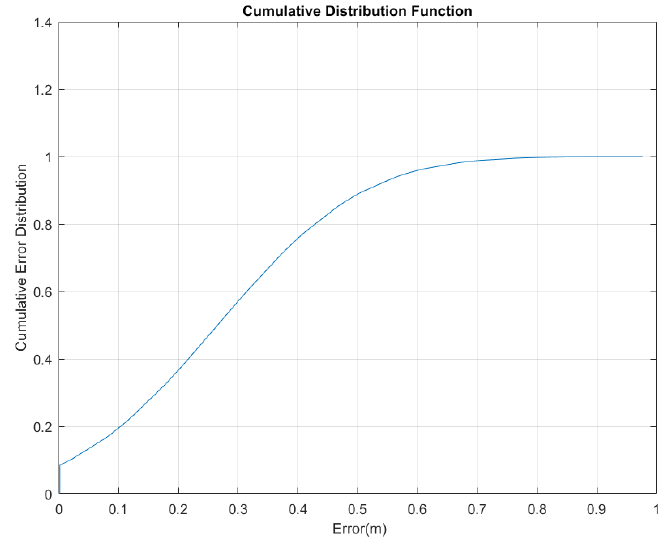
Figure 14. The CDF of the height estimation error.